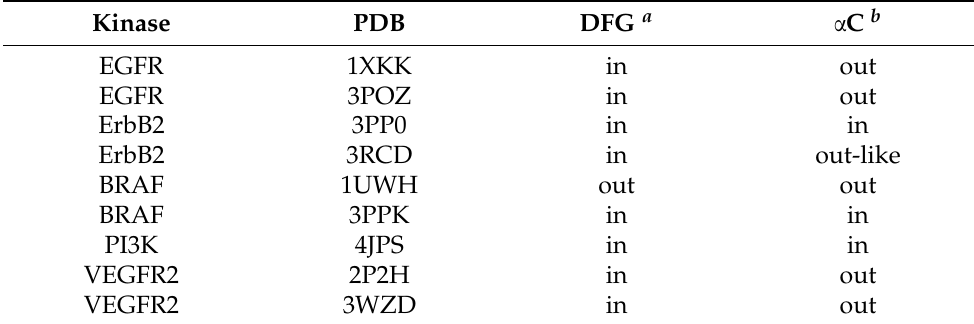
Table 6. Kinase structures used in docking